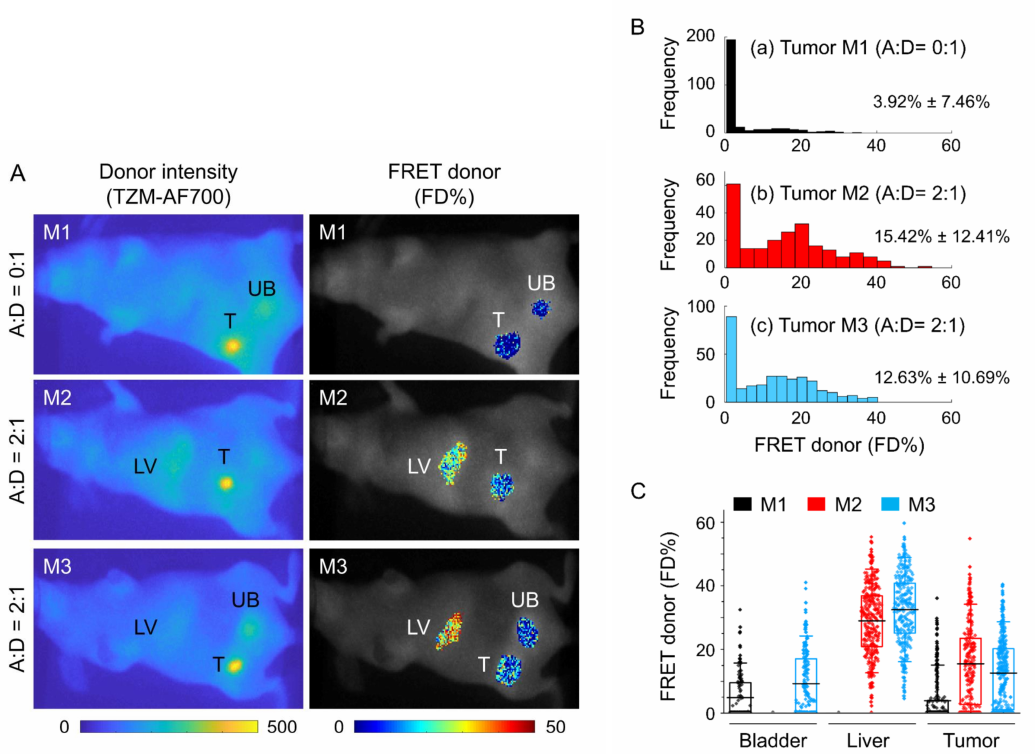
Figure 6. Whole body quantification of TZM–HER2 engagement via MFLI-FRET in vivo imaging. ( A ) Mice were injected with 20 µ g TZM–AF700 alone (M1) or TZM–AF700 and 40 µ g TZM–AF750 and subjected to MFLI-FRET imaging at 48 h p.i. Panels show TZM donor maximum intensity ROIs (both soluble and bound probe) and FRET donor fraction (FD%) map (bound and internalized probe) in the tumors (T), livers (LV), and urinary bladders (UB). ( B ) Histograms of FD% retrieved for each tumor. Numbers represent mean ± SD. ( C ) Quantification of FD% in the tumors, bladders and livers. Data presented as box indicating 25–75% pixel values, horizontal and vertical lines indicate mean with ± 1.5 SD,